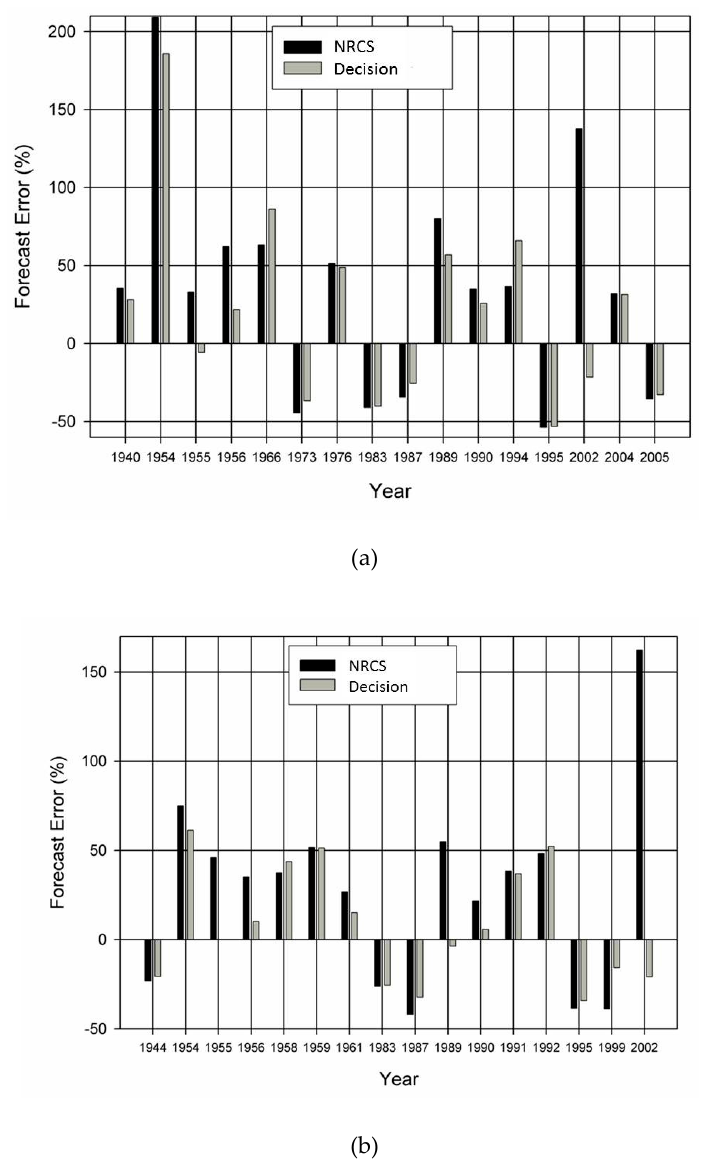
Figure 3. Plot comparing forecasts for the worst quartile of “poor” forecasts using current forecasting methods (NRCS) with proposed methods (decision system) for ( a ) USGS 06620000 ( b ) USGS